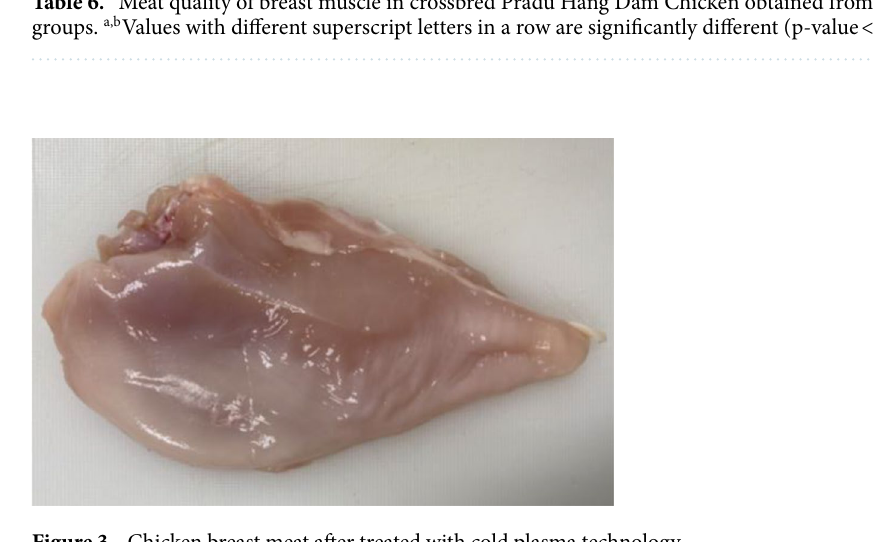
Figure 3. Chicken breast meat after treated with cold plasma technology.